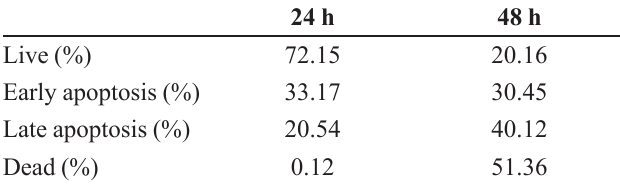
51.36 FIGURE 1 - Effect of mace extract and positive control